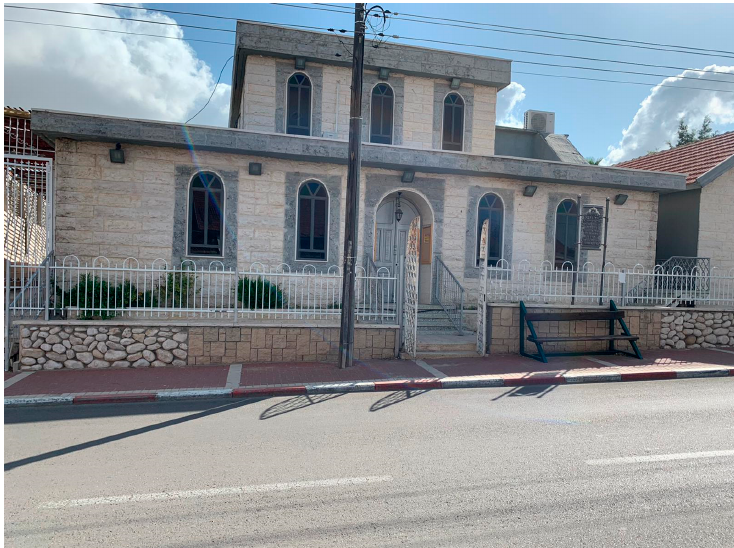
Figure 9. Interior, Bushaeff synagogue, Zeitan (http://www.bushaeff.co.il/, 2020).